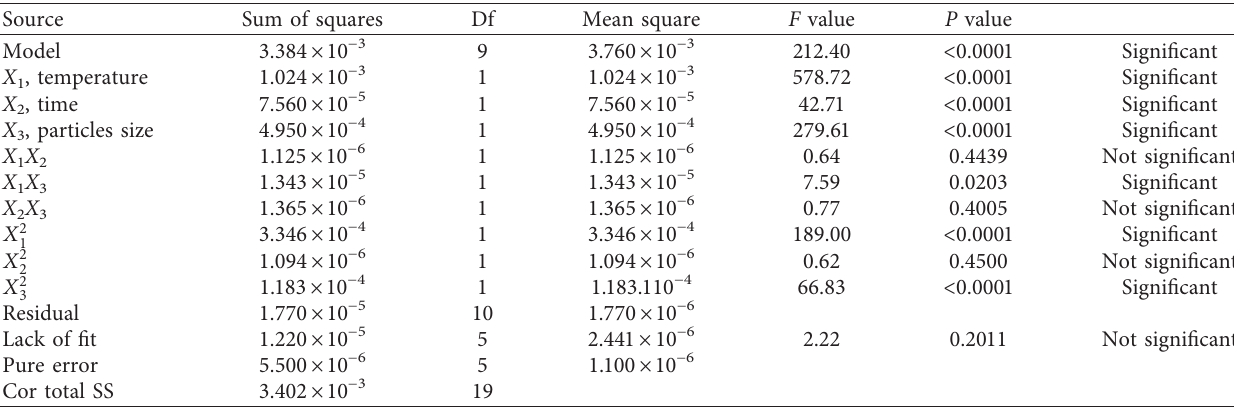
Table 5: ANOVA for surface quadratic model (response: degree of conversion of kaolinite dehydroxylation reaction).